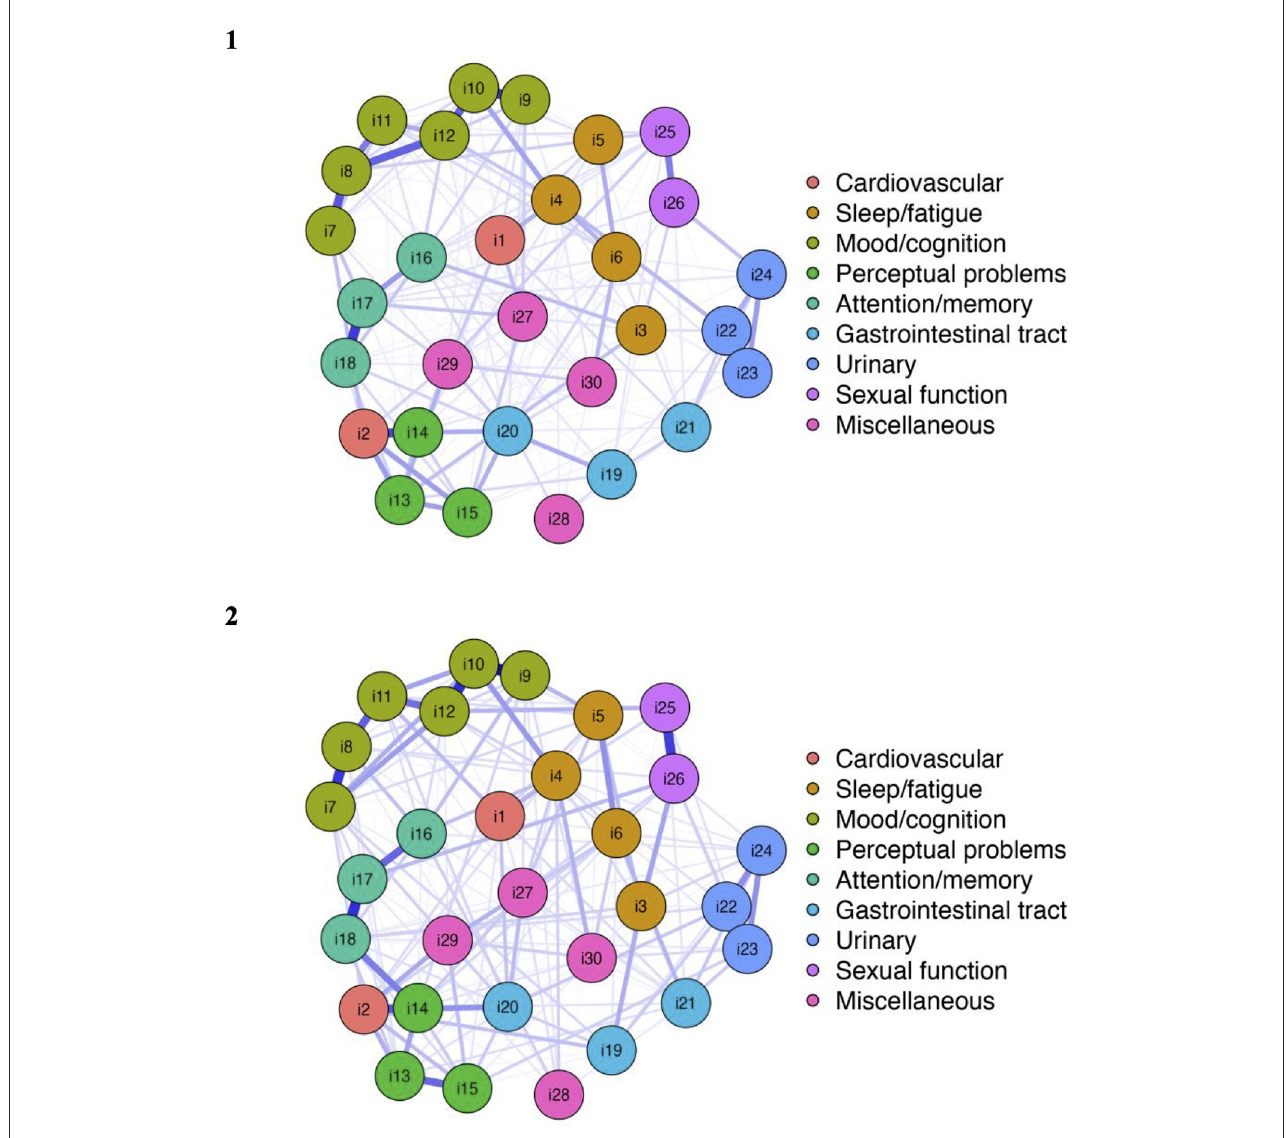
FIGURE1 Network structure NMSS items at baseline and the 2-year